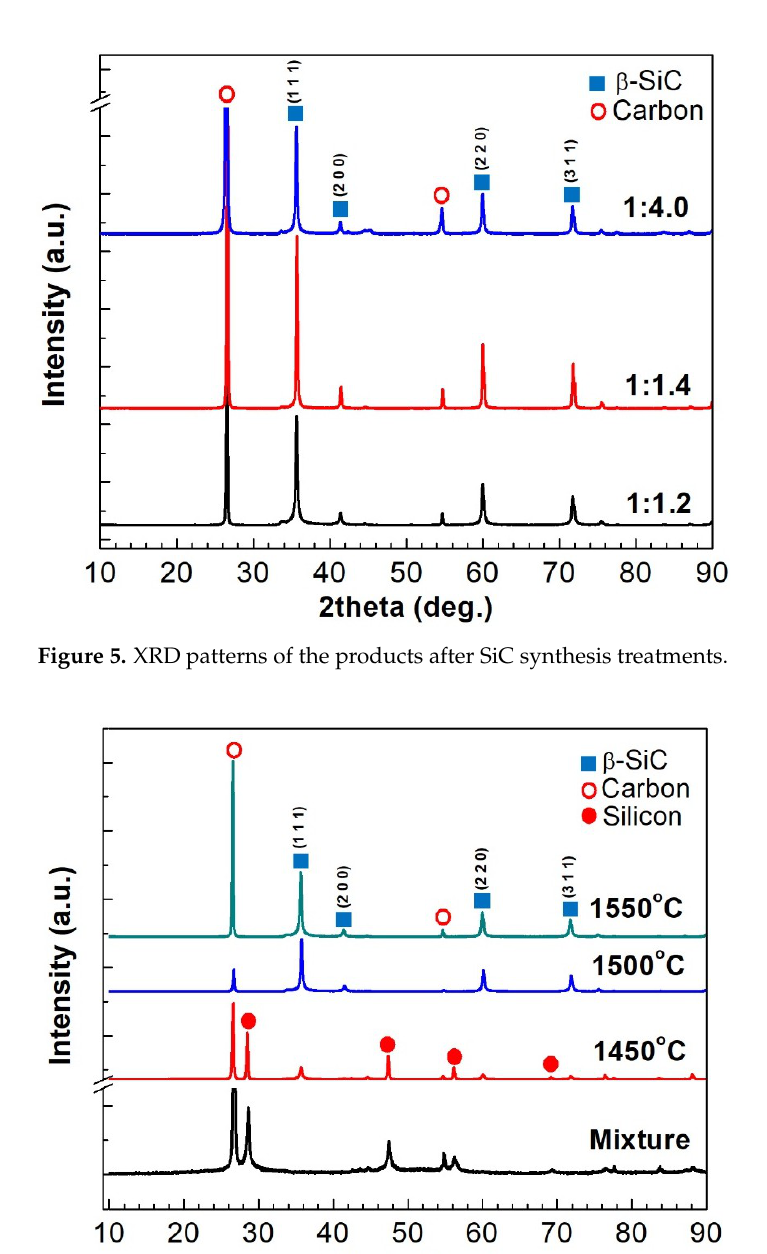
Figure 6. XRD patterns of the products after SiC synthesis at different temperatures (Si sludge-to-C molar ratio = 1:1.4).